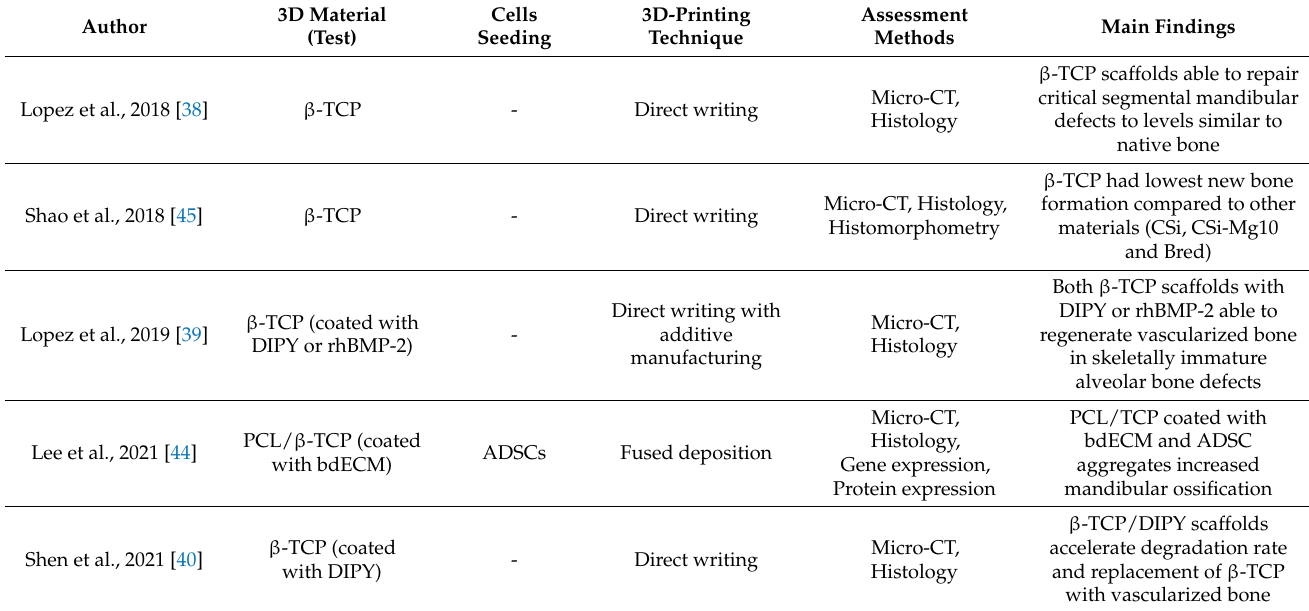
Table 2. Summary of the included studies using 3D TCP-based